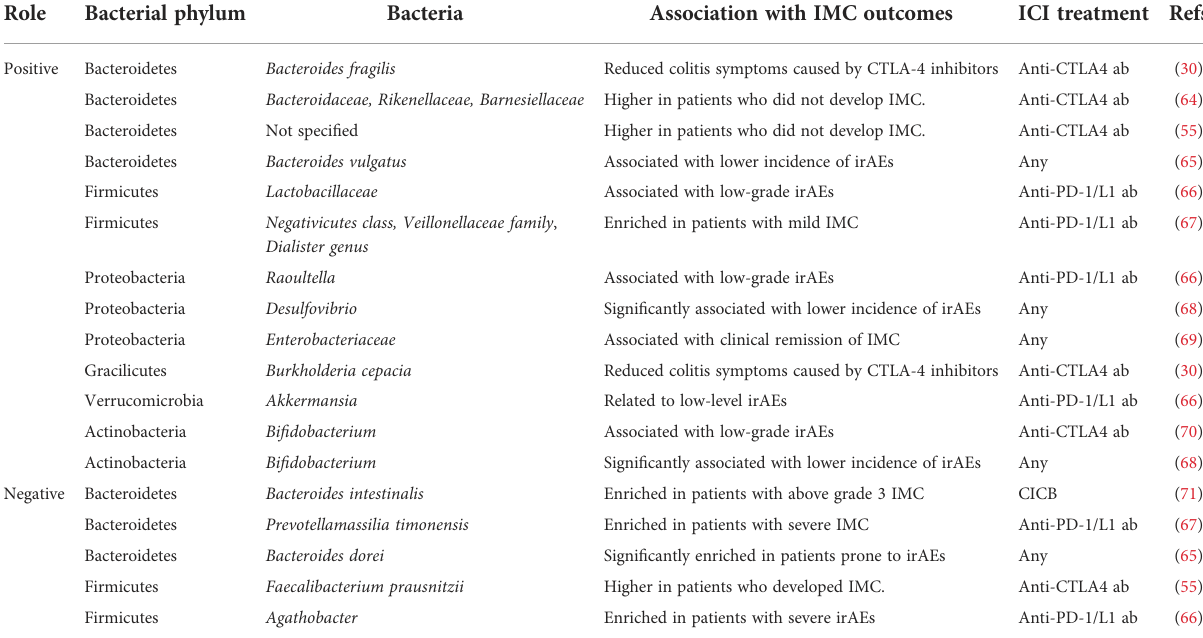
TABLE 1 Microbiota associated with